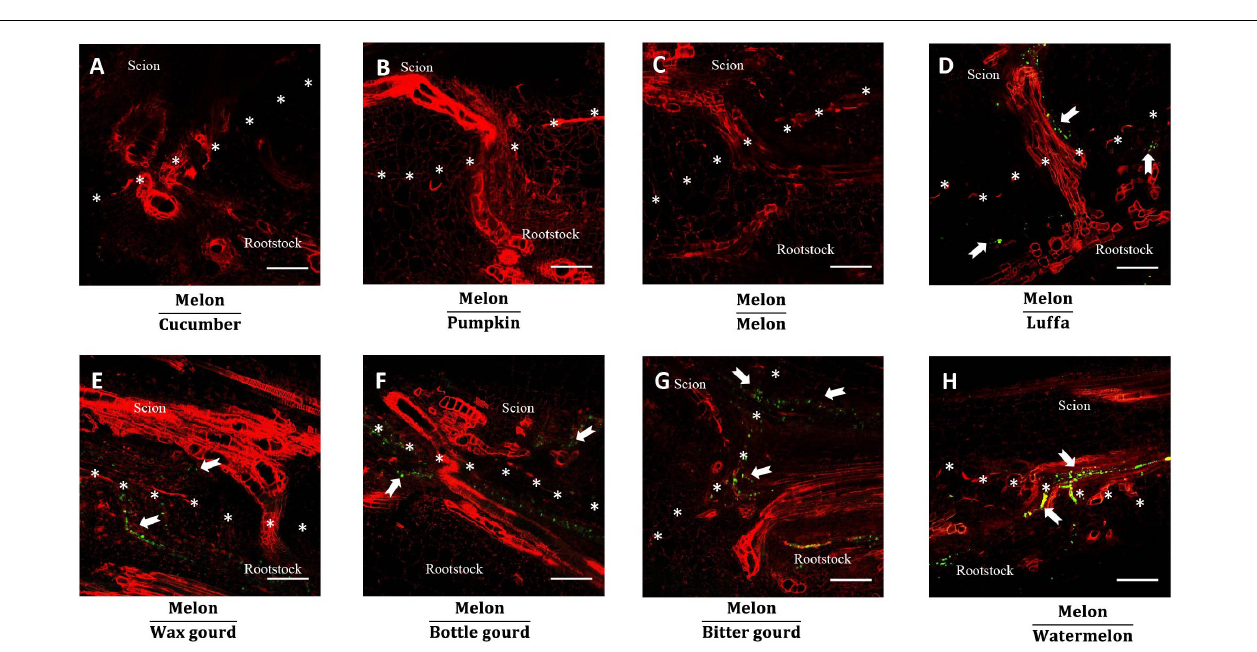
FIGURE 7 | Necrotic layer and vascular reconnection of melon grafted onto eight Cucurbitaceae species. (A–H) Longitudinal sections of the graft junction of melon cv. ‘Akekekouqi’ grafted onto cucumber cv. ‘Jinyou No.35,’ pumpkin cv. ‘Qingyouzhen No.1,’ melon cv. ‘Akekekouqi,’ luffa cv. ‘Sanbi No.6,’ wax gourd cv. ‘Aonong,’ bottle gourd cv. ‘H19,’ bitter gourd cv. ‘Liangku No.1,’ and watermelon cv. ‘Zaojia 8424’ on day 14 after grafting. Asterisks indicate graft junction. Red arrows indicate undegraded necrotic layer fragments. VC, vascular reconnection; NI, necrotic layer. Scale bar represents 250 µ m.